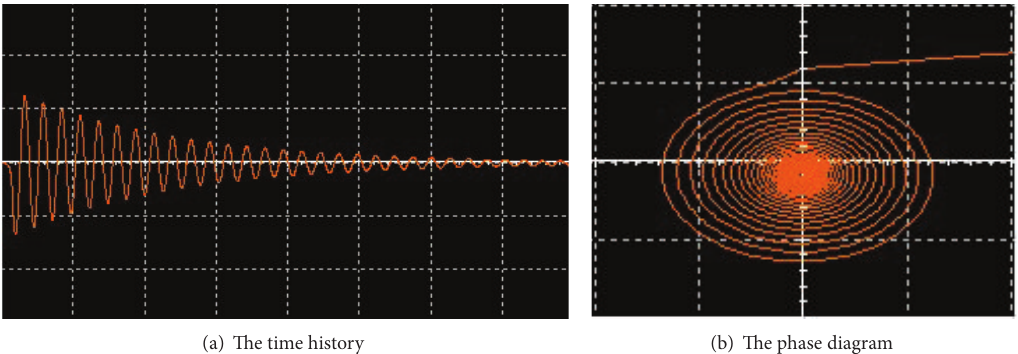
Figure 17: Experimental observations of the time history and phase diagram of system (16) with 𝑎 = 1 , 𝑐 = 0.08 , 𝑚 = 0.5 , 𝑘 1 = 0.8 , 𝑘 2 = 0.5 , and 𝑏 = −0.2 .